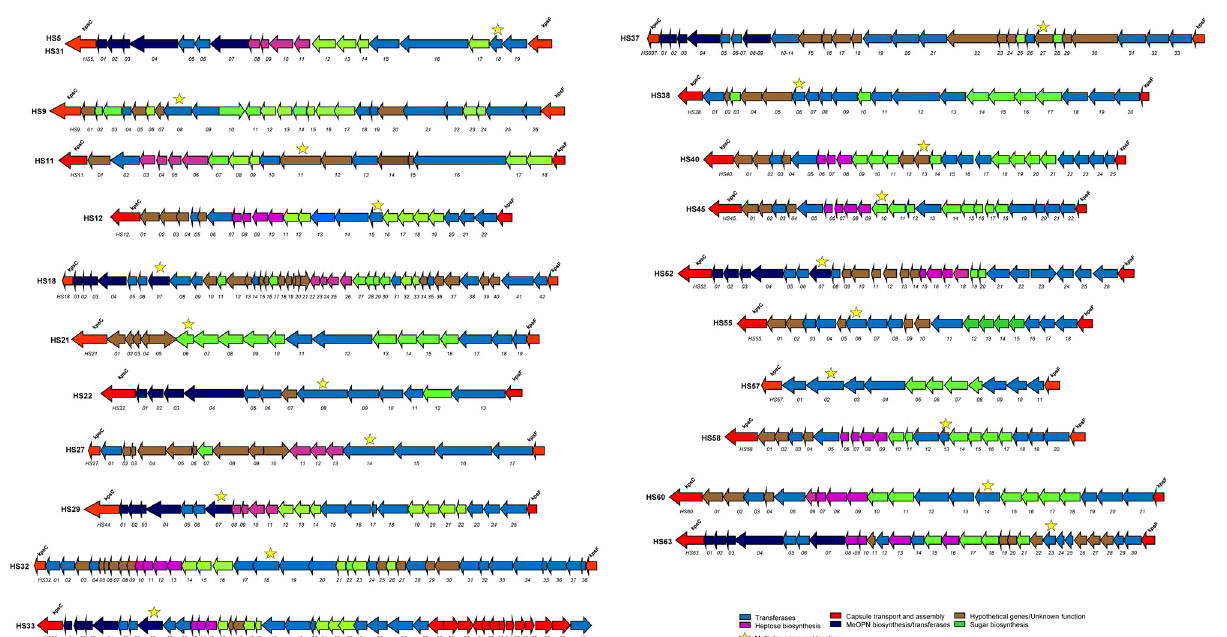
Fig 2. Illustration of the C . jejui CPS loci described in this study. Putative gene functions were assigned via homology to a protein database by BLAST analyses.